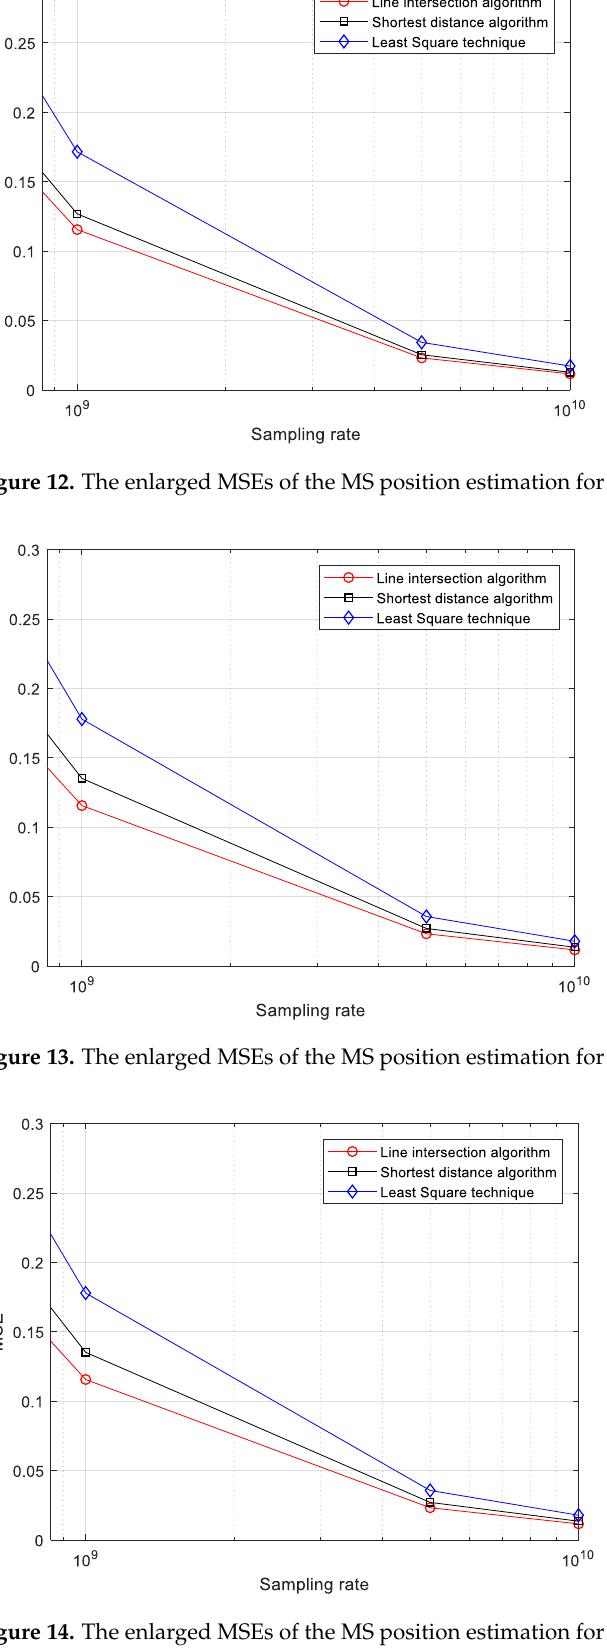
gorithms for the third case.